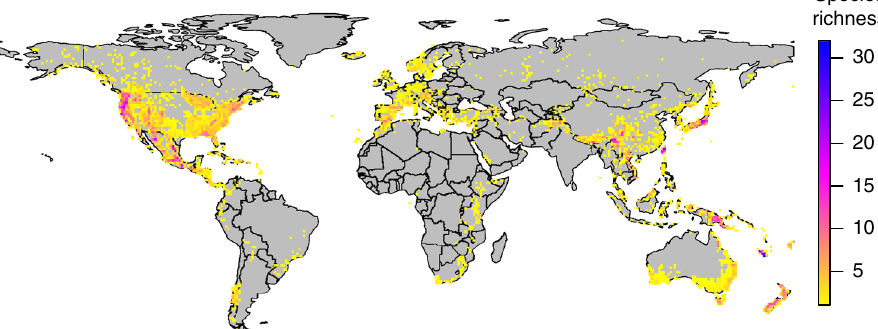
Fig. 1 Conifer species richness. Global species richness patterns in 455 conifer species based on cleaned empirical distribution data used here to analyse diversi fi cation processes. See Supplementary Fig. 1 for equivalent map of all 600 recognised living conifer